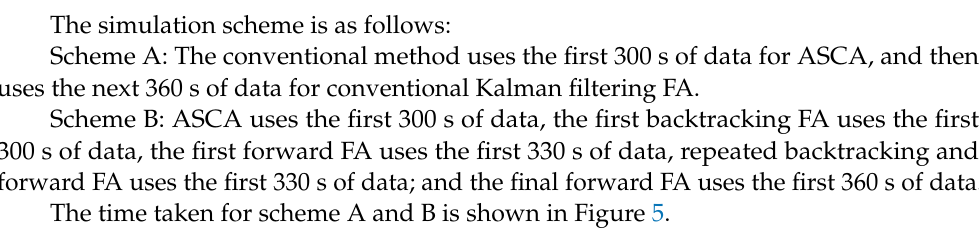
Figure 4. The trajectory of the LV swaying with the offshore launch platform.